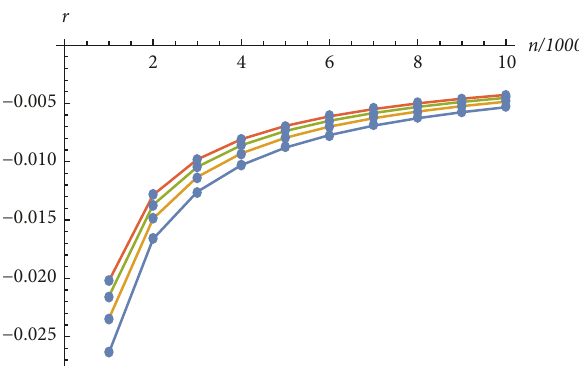
Figure 5: Newman assortativity coefficient 𝑟 for BA networks with 𝛽 = 1,2,3,4 and largest degree 𝑛 = 1000, 2000,. .. ,10000 . The upper curve is for 𝛽 = 1 , and the curves for the values 𝛽 = 2, 3,4 follow, from the top to the bottom.